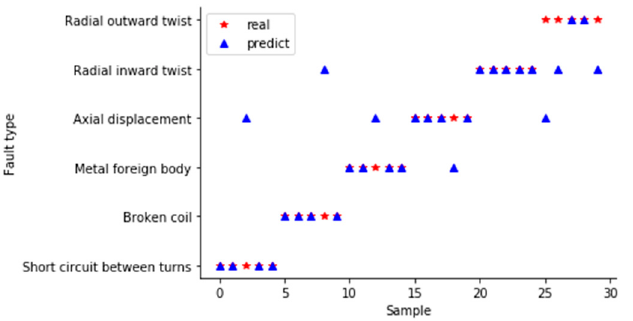
Figure 14. Performance of particle swarm optimization (PSO)-SVM on validation set.